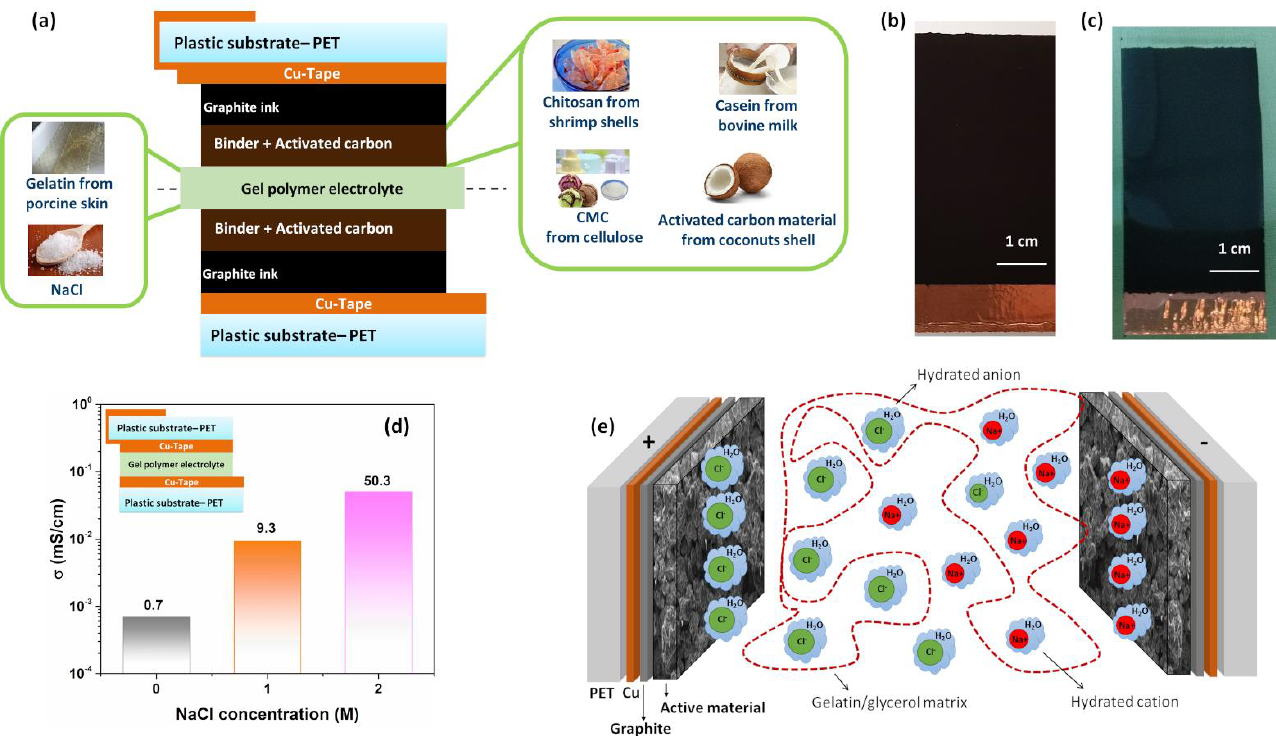
Figure 1. ( a ) Cross section of the symmetric carbon-based supercapacitors fabricated with sustainable materials; ( b , c ) photographs of the top view of the half structure of the device before and after the deposition of the transparent hydrogel, respectively; ( d ) ionic conductivity at 300 K as a function of the NaCl concentration within the hydrogel; ( e ) schematic diagram of a hydrogel polymer electrolyte (gelatin/NaCl/H 2 O) between two carbon electrodes. The cross section of the cell structure used to perform the conductivity measurements within the electrolyte is shown in the inset.